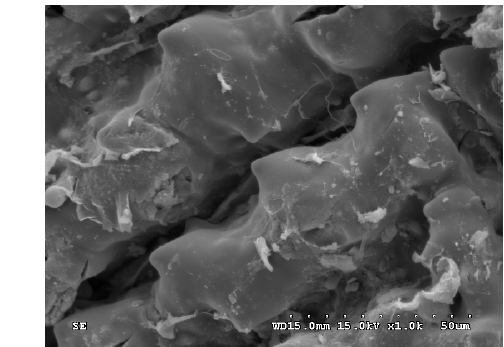
Figure 5. SEM images (×200, left; ×1000, right) of the resulting biochar (BRH-900-30).